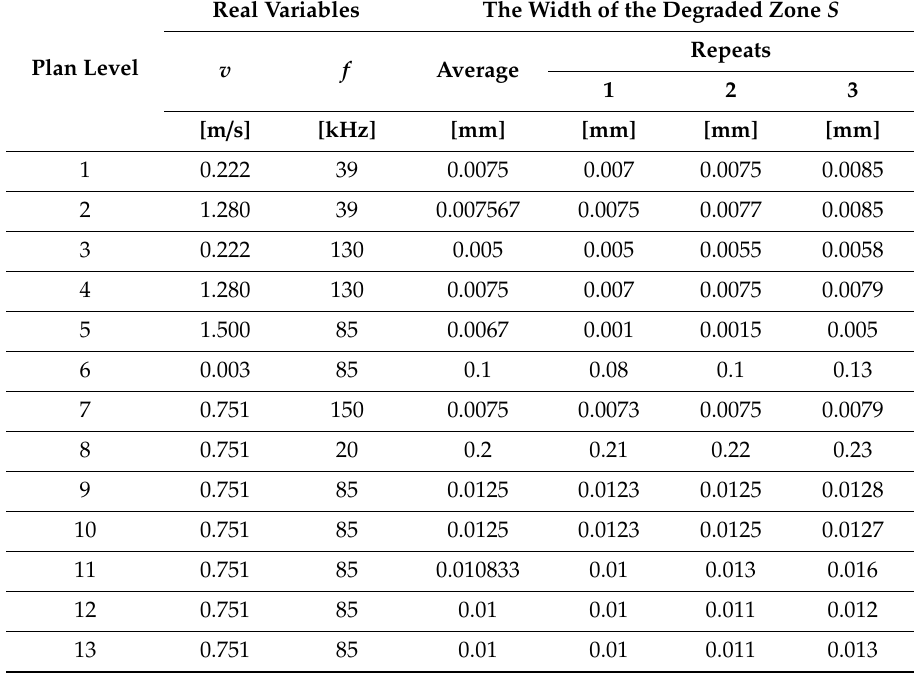
Table 6. The matrix of the experiment plan according to the five-level plan with the results for the film thickness t = 70 µ